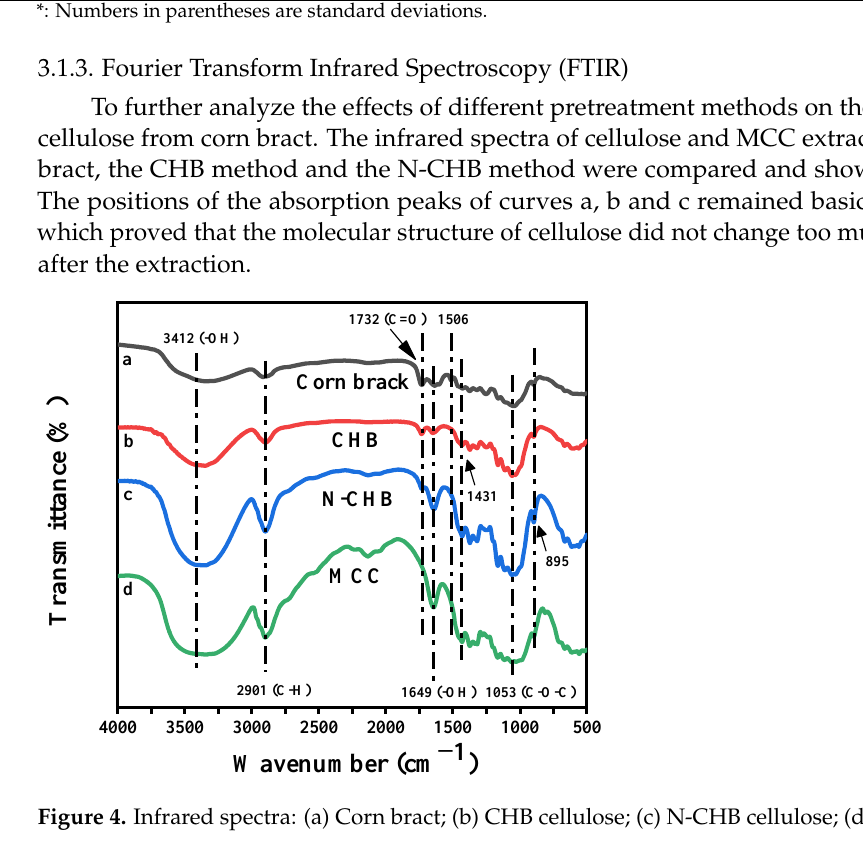
Table 1. Content of the three major elements in corn bract powder and cellulose samples *.